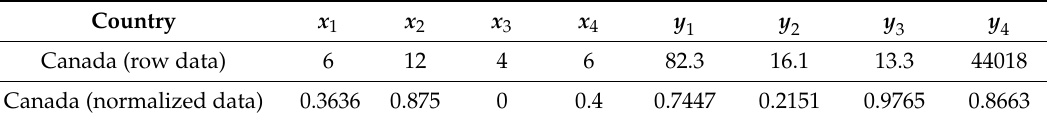
Table 8. Initial data and normalized data for